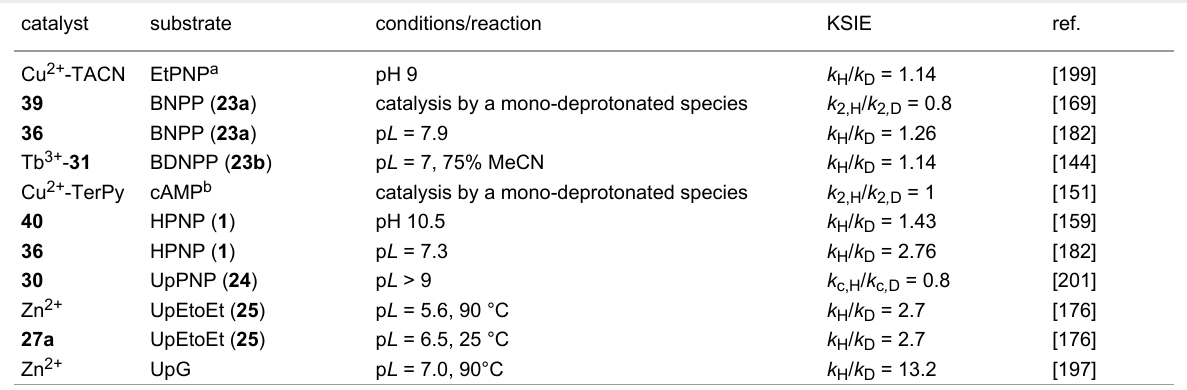
Table 7: Solvent isotope effects reported for reactions of phosphodiesters in the presence of metal ion catalysts.